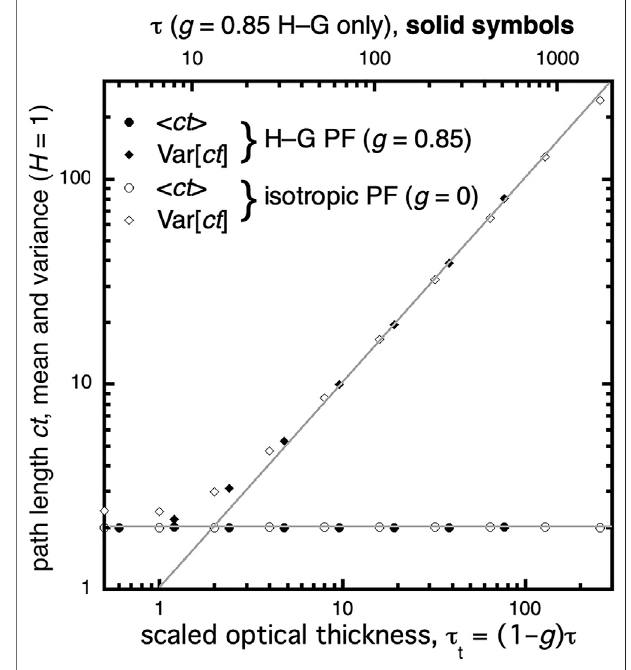
FIGURE1| Pathlengthmoments 〈 L 〉 andVar[ L ]( τ )areplottedversus τ in log-log axes.SymbolsmarktheMonteCarlosimulation results, whilediffusion model outcomes are solid lines. The invariance of 〈 L 〉 is veri fi ed exactly. Furthermore, the diffusion-theoretical prediction that Var[ L ]( τ ) = (1 − g ) τ / 2 χ (with extrapolation scale factor χ set to 2/3) becomes very accurate at τ − g ) τ ~4. Two phase functions were investigated: g = 0 (isotropic t = (1 scattering) and g = 0.85 (forward-peaked Henyey and Greenstein (1941) scattering). Adapted from Davis et al. (2021), where 〈 L 〉 is denoted 〈 ct 〉 .